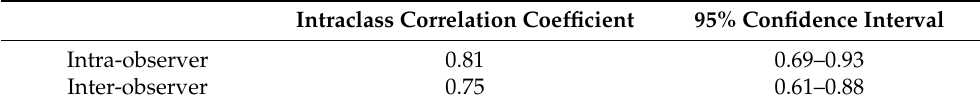
Table 3. Intra- and inter-observer reliability of the intraepithelial papillary capillary loop classification.